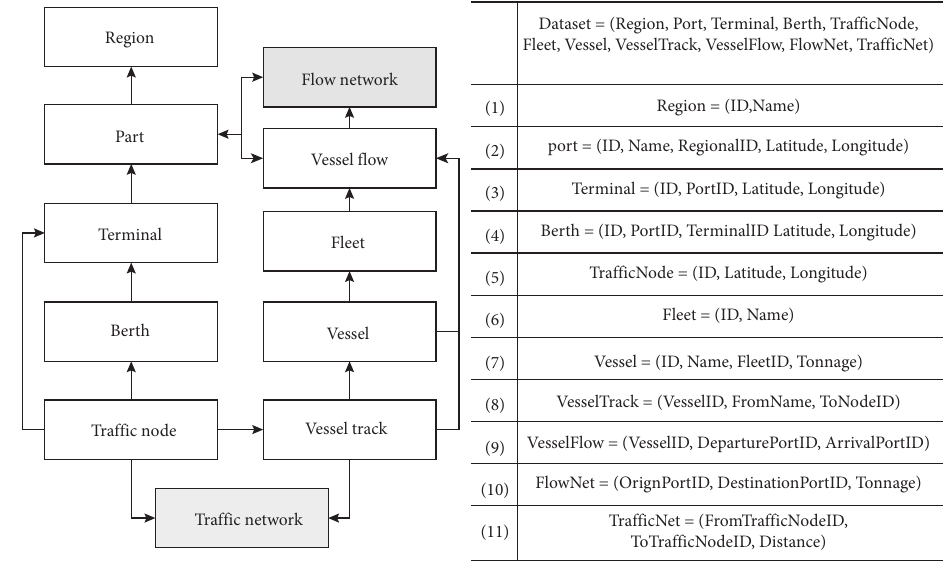
Figure 5: Data structures in the shipping earth project.